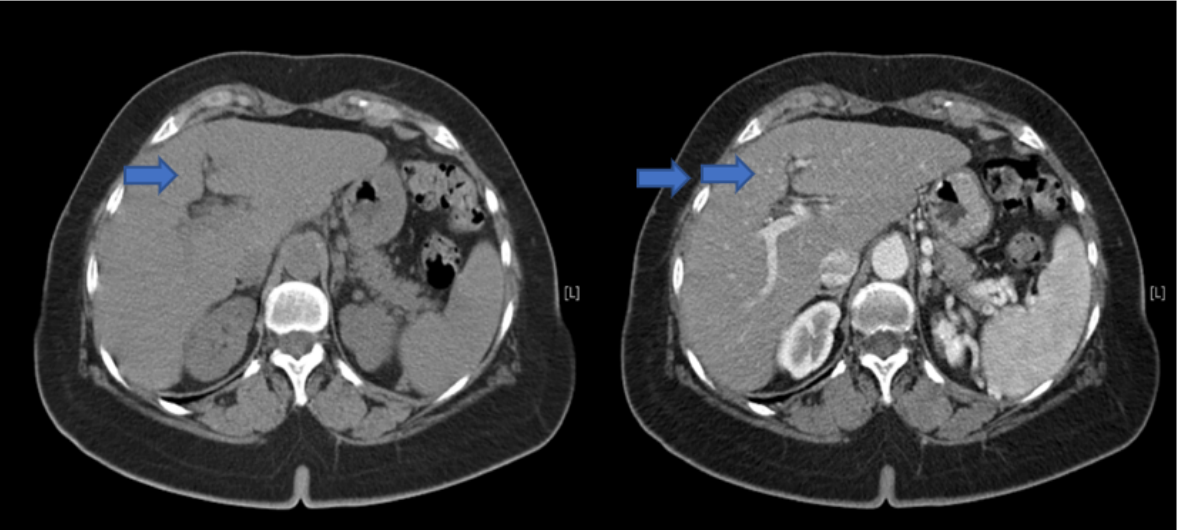
Figure 1. Combination or double image CT scan of the liver, without (blue arrow) and with (double blue arrow) contrast medium, which does not show significant alterations of the intra-hepatic vessels nor dilatations of the biliary ducts.